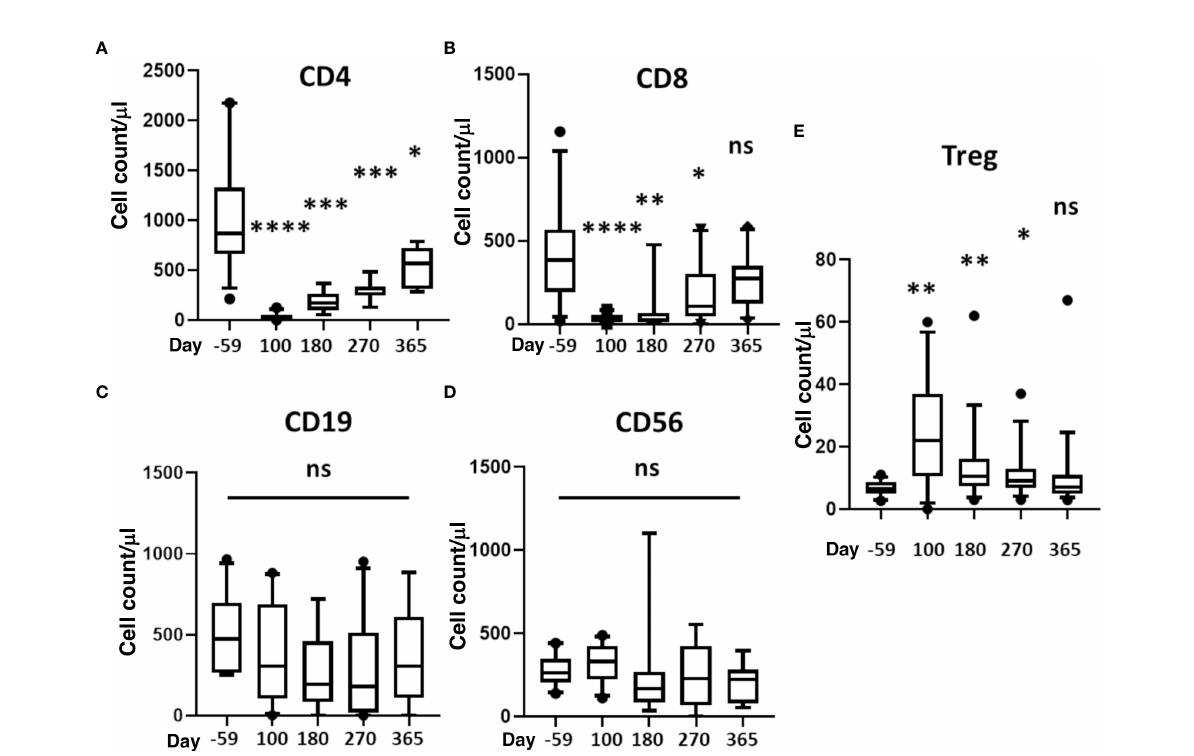
FIGURE 3 Reconstitution of T, B, NK, and Treg cells. Absolute cell counts were determined for (A) CD4 + T-cells, (B) CD8 + T-cells, (C) B cells, (D) NK cells (CD3 - /CD56 + ), and (E) Treg (CD4 + CD127 dim CD25 hi Foxp3 + ). Measurements were made at baseline (day -59) and 100, 180, 270, and 365 days after HSCT. Statistically signi fi cant differences between baseline and post-HSCT timepoints are indicated as **** P<0.0001, *** P<0.005, ** P<0.001, * P<0.05. Differences that are not signi fi cant are labeled, ns. NK, natural killer; Treg, regulatory T cells; HSCT, hematopoietic stem cell transplantation; ns, not signi fi